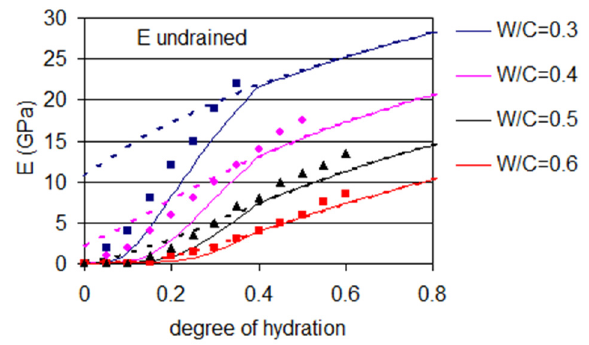
Figure 5. Prediction of the evolution of elastic modulus with percolation law (solid lines) and without (dotted lines) in undrained conditions (experimental measurements from